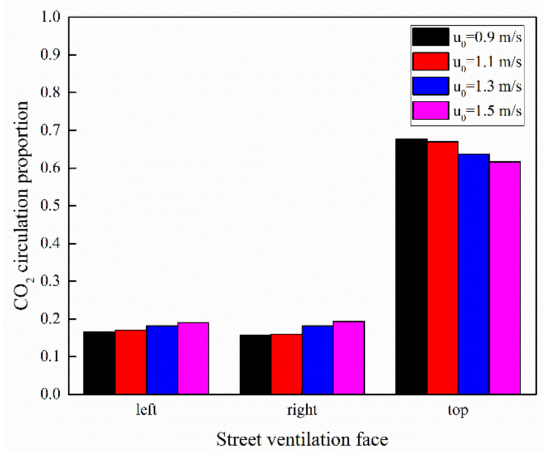
Figure 21. Flux proportion of pollutants per unit area of street ventilation surfaces with different characteristic wind speeds.